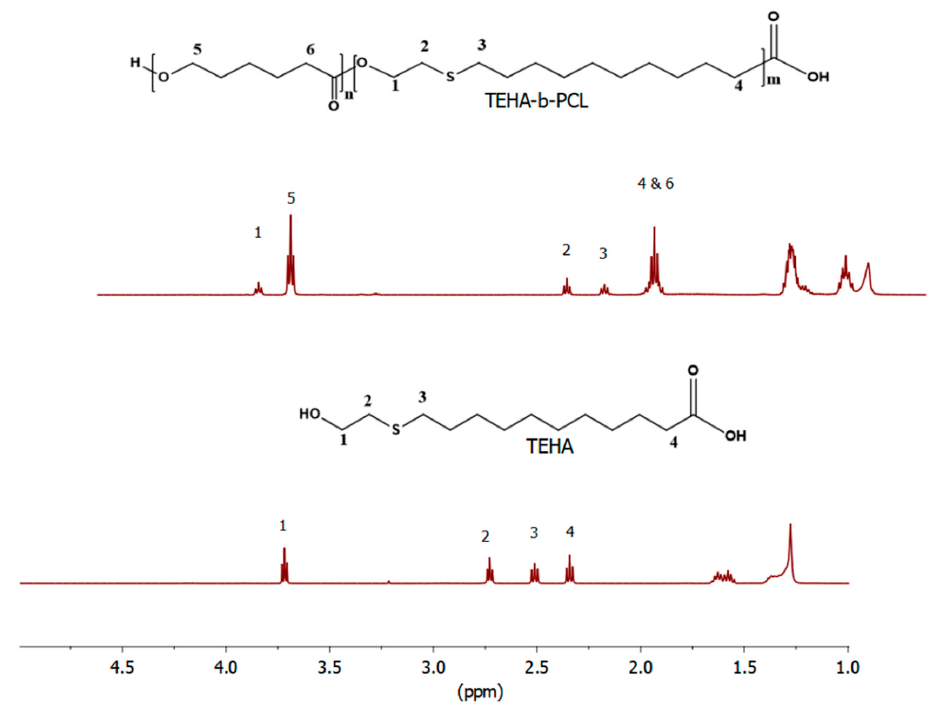
Figure 1. 1 H-NMR spectra of TEHA and TEHA-b-PCL diblock copolymer.